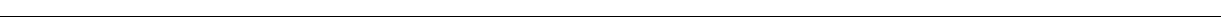
2c). To identify potential kinase(s) that would mediate FBXW2 phosphorylation at the b -TrCP1 binding motif (SSGART), we searched computer database (GSP 3.0